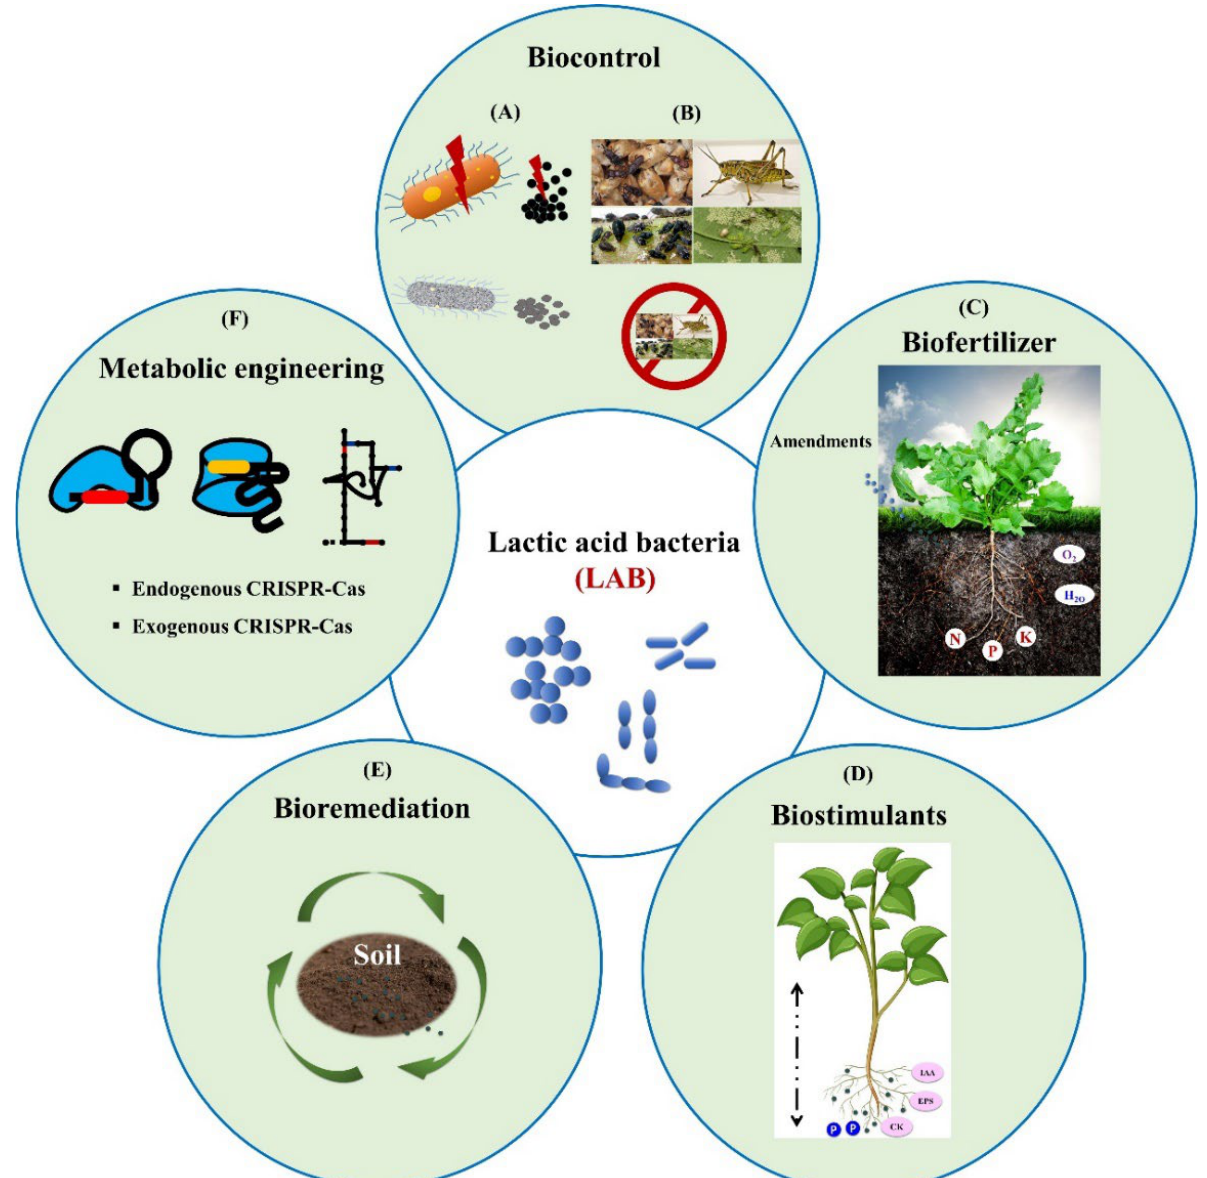
Figure 1. Lactic acid bacteria agricultural application. ( A ). Anti-bacterial and anti-fungal activity; ( B ) biopesticides and insecticides; ( C ) biofertilizer increases soil fertility, aeration and retention of moisture content, elevates the mineral uptake and organic decomposition, acetifies the soil and re- duces pest diseases. ( D ) IAA, cytokinin, and siderophore secretion increases the root and shoot length and solubilizes the phosphate in the soil. ( E ) Heavy metal removal, detoxification of fungal mycotoxins, acidification by LA and organic acid, increases organic decomposition, and increases the organic content in the soil, biodegradation. ( F ) CRISPR-Cas systems and derived molecular ma-